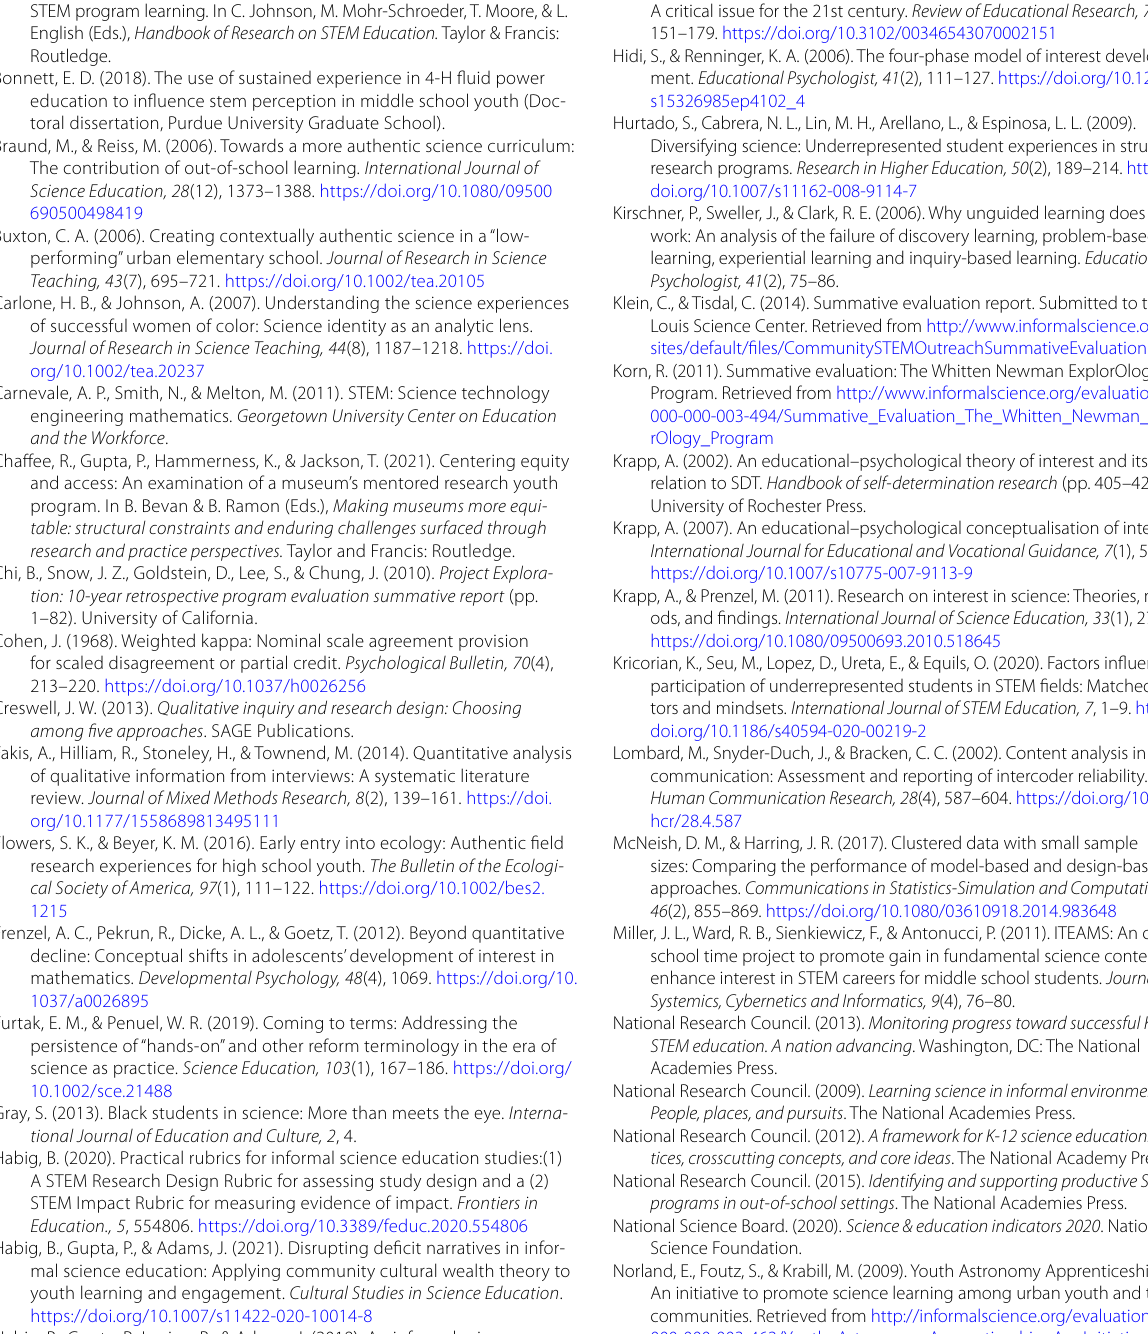
table: structural constraints and enduring challenges surfaced through research and practice perspectives. Taylor and Francis: